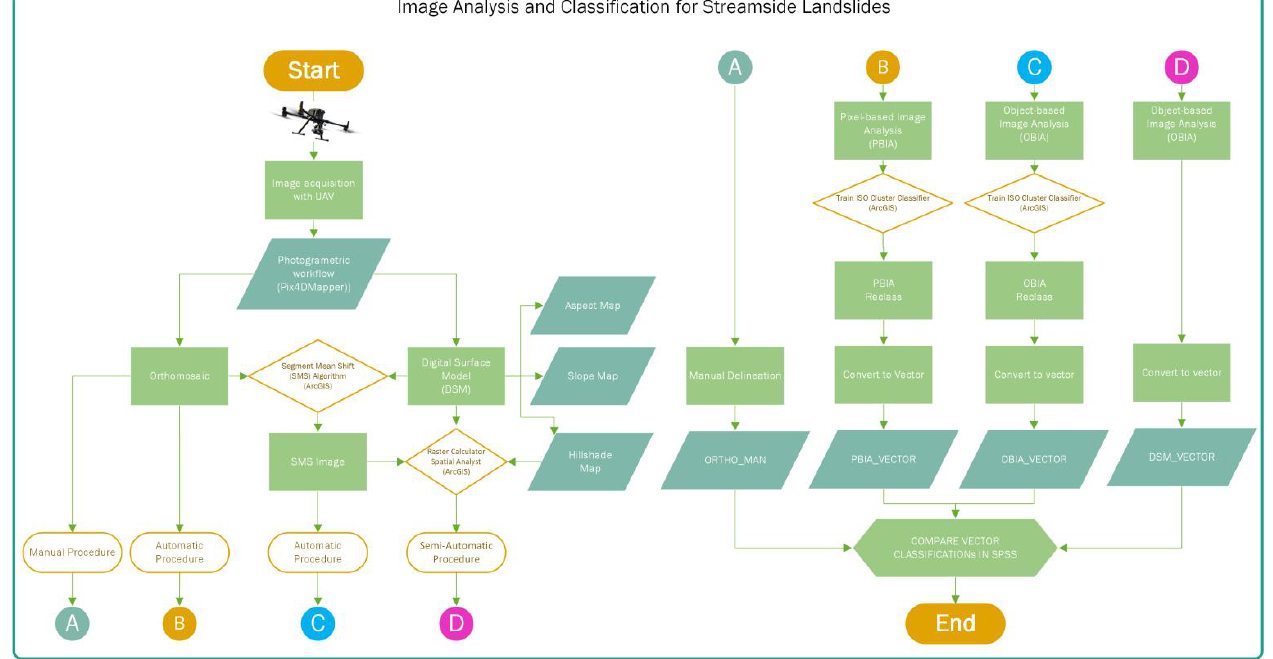
Figure 8. The flowchart of the methodologies used in this study.